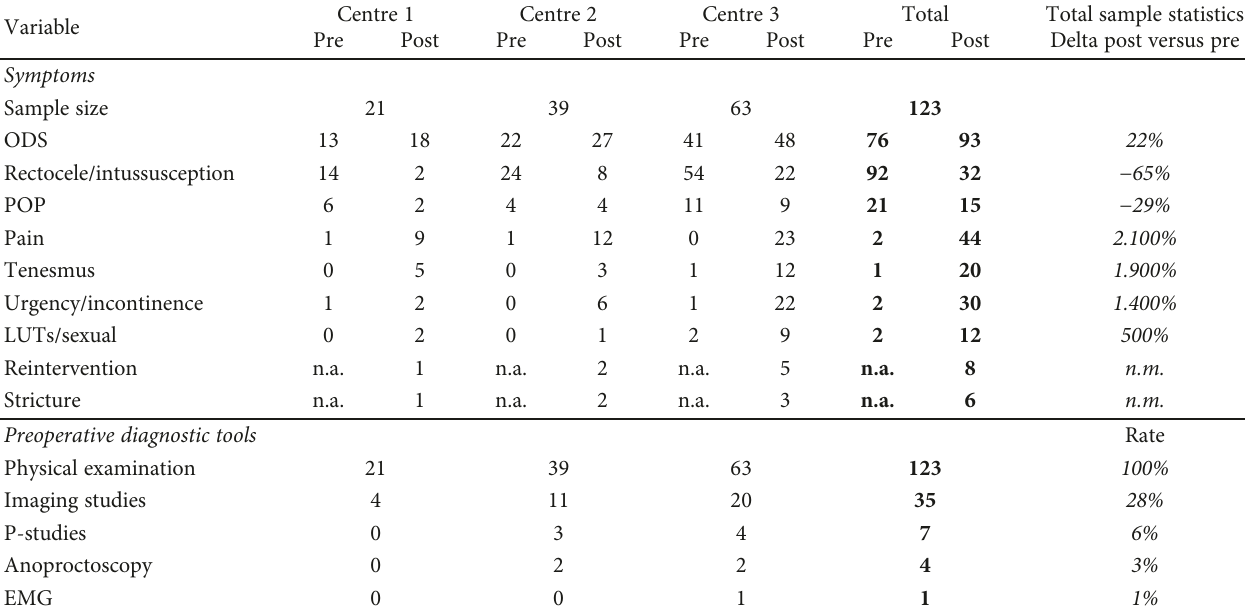
Table 2: Comparison of pre-postoperative symptoms and use of preoperative diagnostic tools by centre in the patient population. Variable